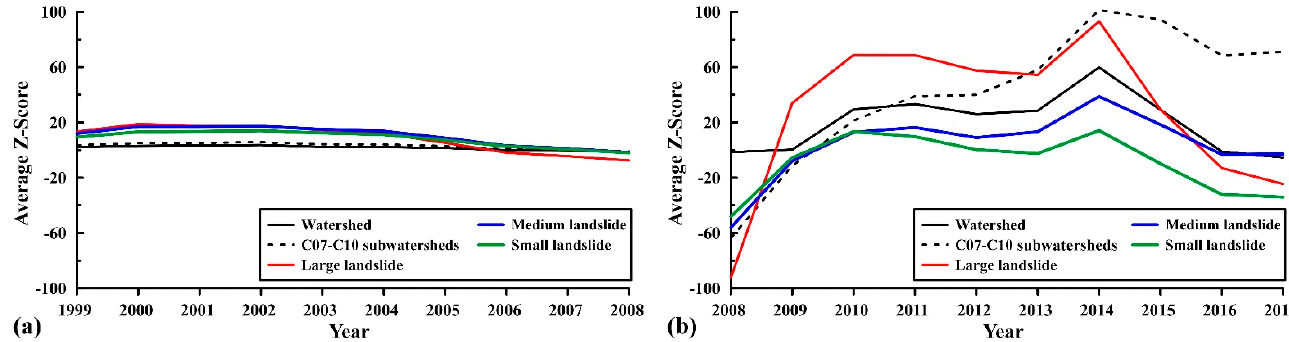
Figure 10. Temporal distribution of average Z-scores in the Chishan river watershed (black line), up- stream subwatersheds (C07–C10, black dash line), large landslide cases (red line), medium landslide cases (blue line), and small landslide cases (green line) in 1999–2008 ( a ) and 2008–2017 ( b ).